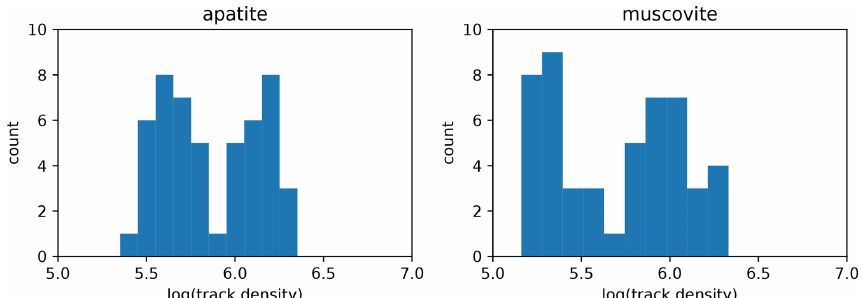
Figure 1. Frequency histograms illustrating the areal track density of the training datasets. The horizontal axis expresses the 10-based log of the areal track density of the training dataset.